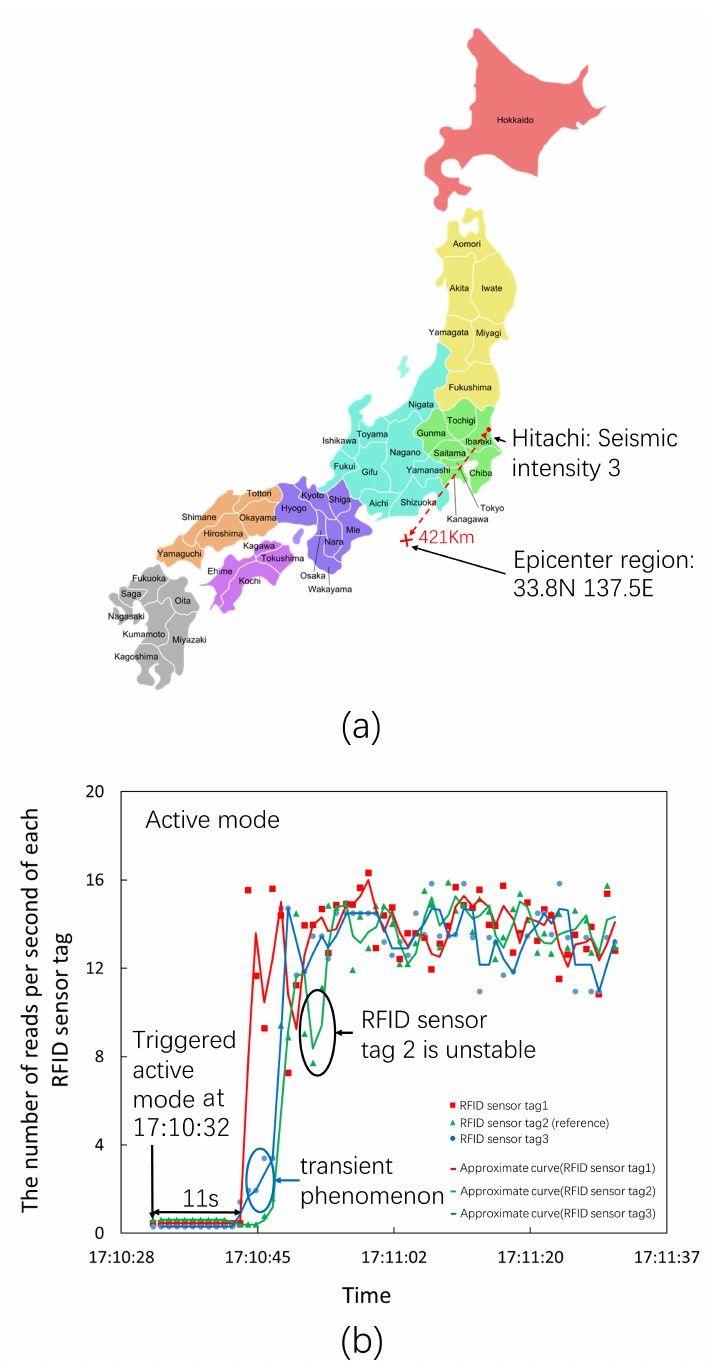
Figure 15. The number of reads per second of three RFID sensor tags at an earthquake seismic intensity of three. ( a ) The epicenter region and the seismic intensity in Hitachi; ( b ) the number of reads per second of each RFID sensor tag; the RFID sensor tags triggered the active mode at 17:10:32. Figure 15b shows the time series data obtained by the three RFID sensor tags. These RFID sensor tags triggered the active mode at 17:10:32. The metric of RFID sensor tag 1 first returned to the ordinary level 11 s after the beginning of the active mode. The metric of RFID sensor tag 3 started to rise at almost the same time as that of RFID sensor tag 1 and then returned to the ordinary level through an obvious transient response. Finally, the metric of the reference RFID sensor tag 2 returned to the ordinary level through an